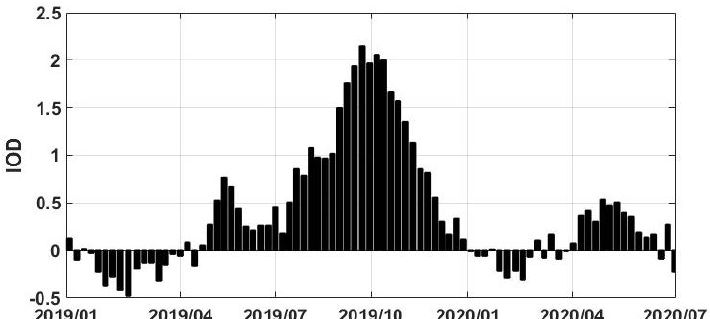
Figure 12. IOD time series for the study